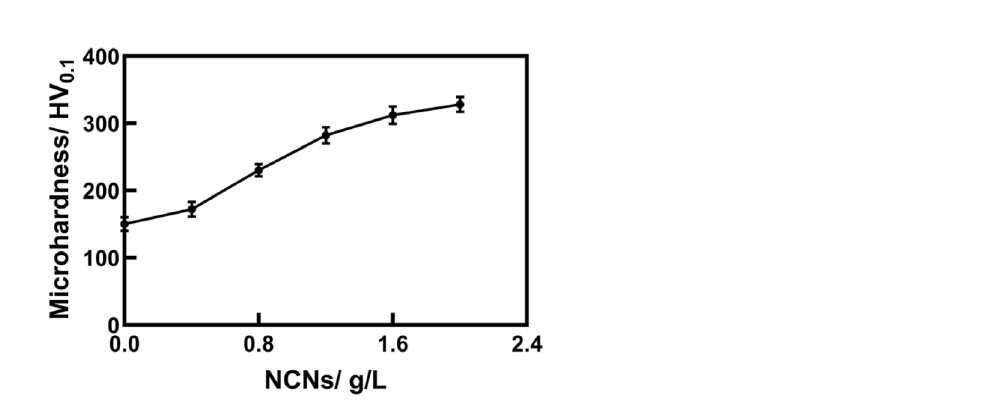
Figure 8. The surface microhardness of MAO coatings (OriginPro 2018, https:// www. origi nlab. com/ index. aspx? go= Produ cts/ Origin).